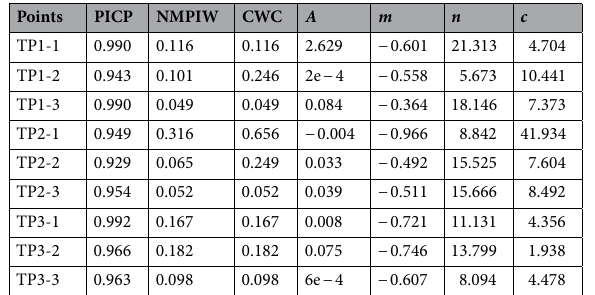
Table 1. Evaluation indices of the PIs and creep model parameters at the control points.